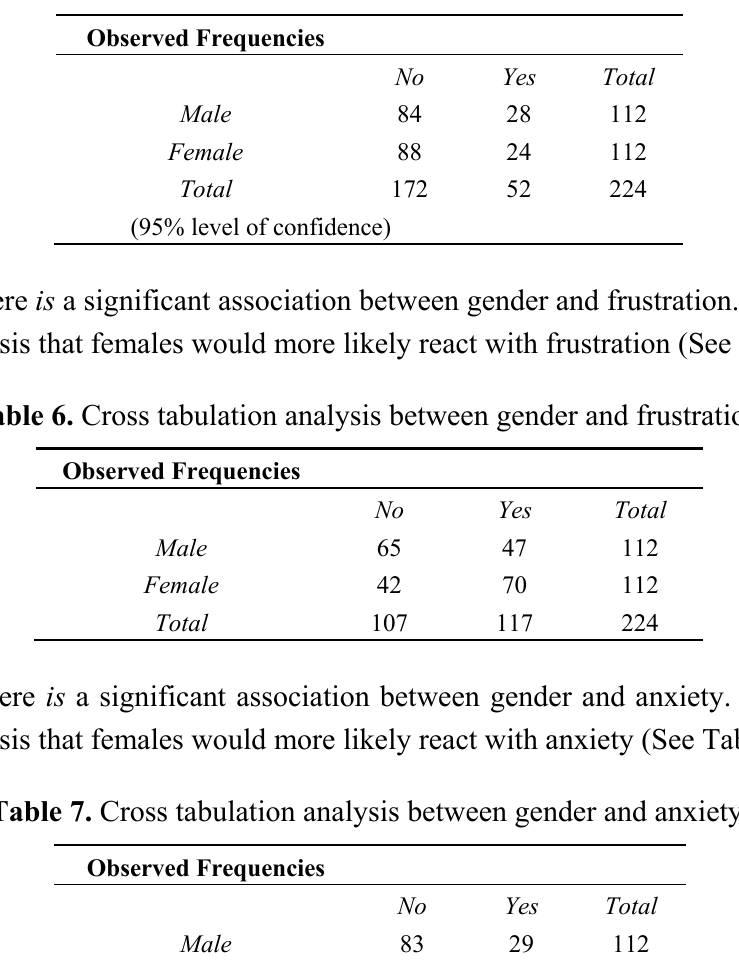
Table 5. Cross tabulation analysis between gender use stress reduction techniques.